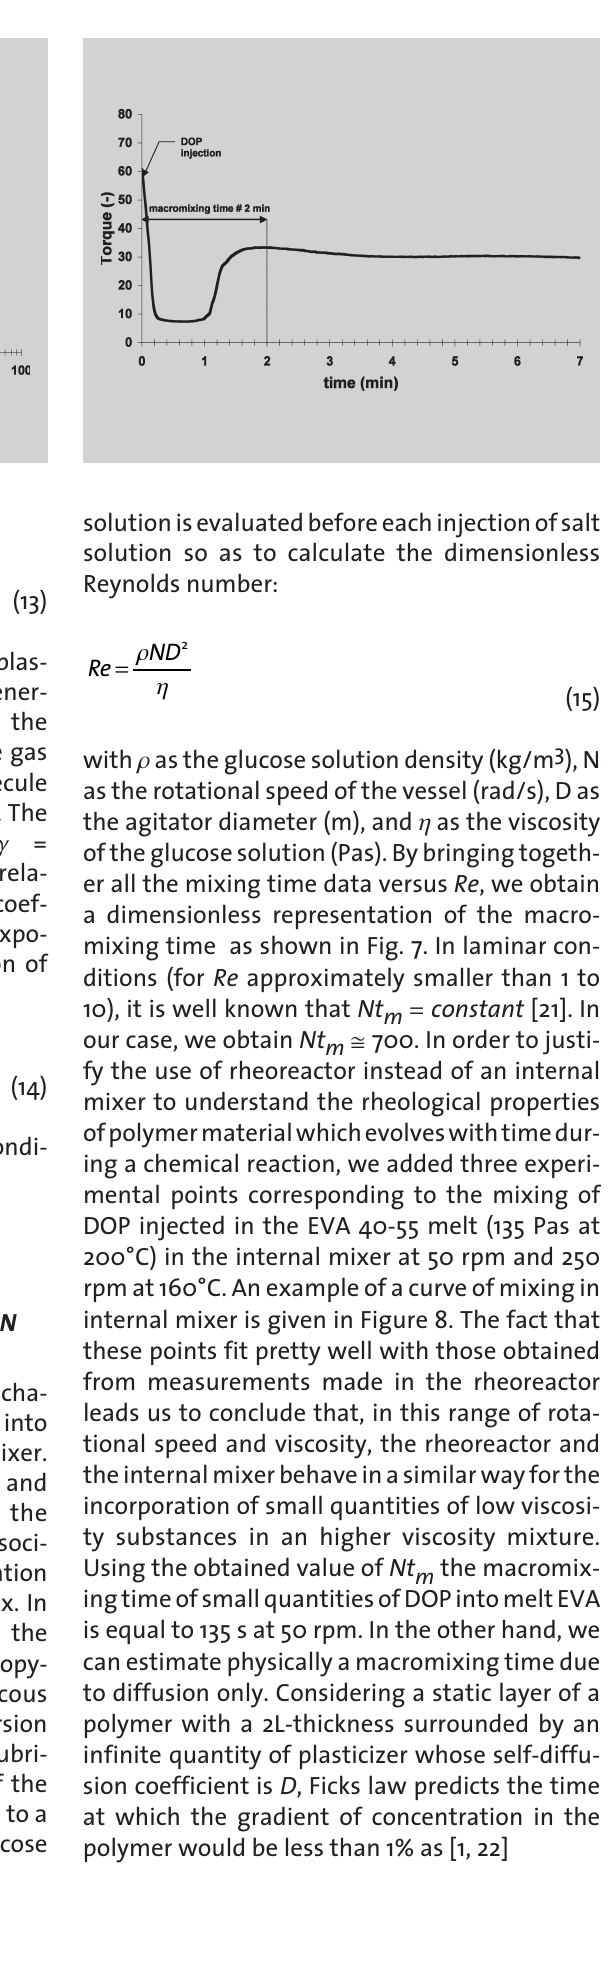
Figure 7 (left): Nt m versus Re (Full symbols: mixing of 1 ml of saturated salt solution (1.2 mPas) injected in glucose solutions of different viscosities in the rheo-reactor (double helicoï- dal ribbon agitator; Clear triangle: mixing of 7.5 ml of DOP injected in EVA 40-55 melt (135 Pa.s at 200°C) in the internal mixer at 50 rpm; Clear circle: mixing of 12.5 ml of DOP injected in EVA 40-55 melt (135 Pa.s at 200°C) in the internal mixer at 50 rpm; Star: mixing of 7.5 ml of DOP injected in EVA 40-55 melt (135 Pa.s at 200°C) in the internal mixer at 250 rpm). Figure 8: Macromixing curve for the incorporation of 7.5 ml of DOP injected in 50 ml of EVA 40-55 melt at 160°C and 50